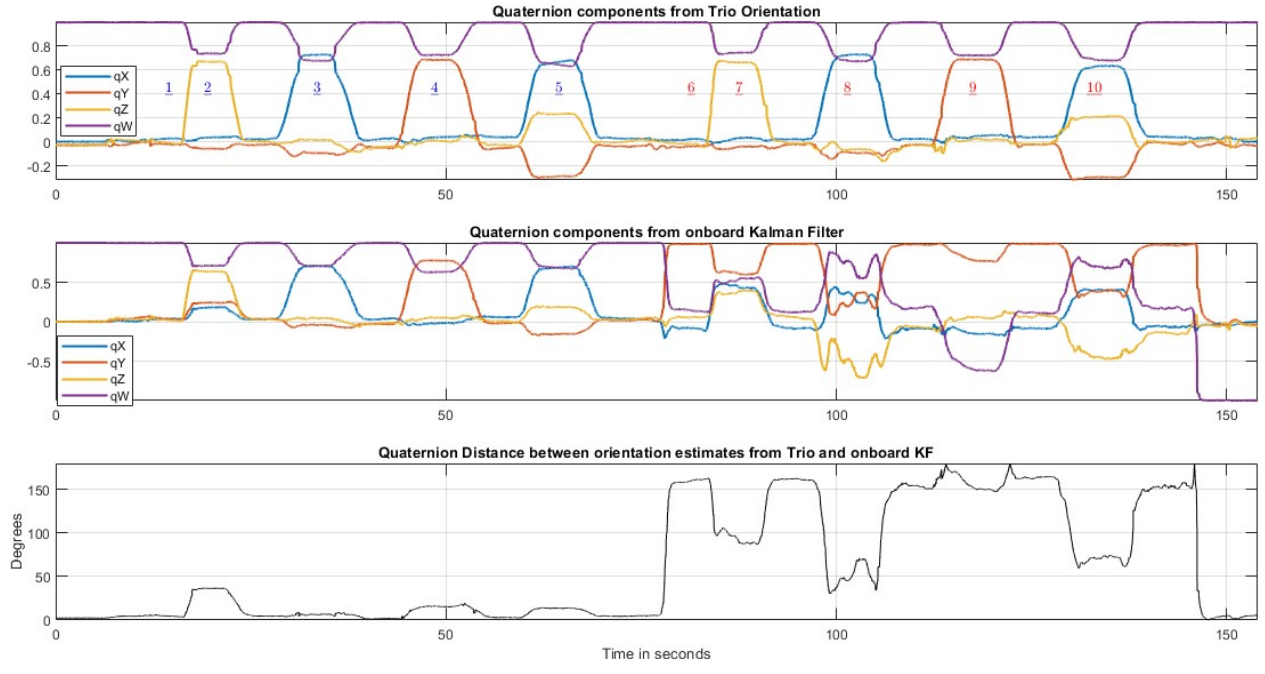
Figure 5. From top to bottom: temporal evolution of the four components of the rigid body quaternion estimate from the Trio system as a quaternion (converted to the MARGs left-hand frame); temporal evolution of the four components of onboard Kalman filter quaternion estimate; and temporal evolution of the “quaternion distance” [33] (angle) between the two orientation quaternions plotted above. (Underlined numbers indicate the poses).